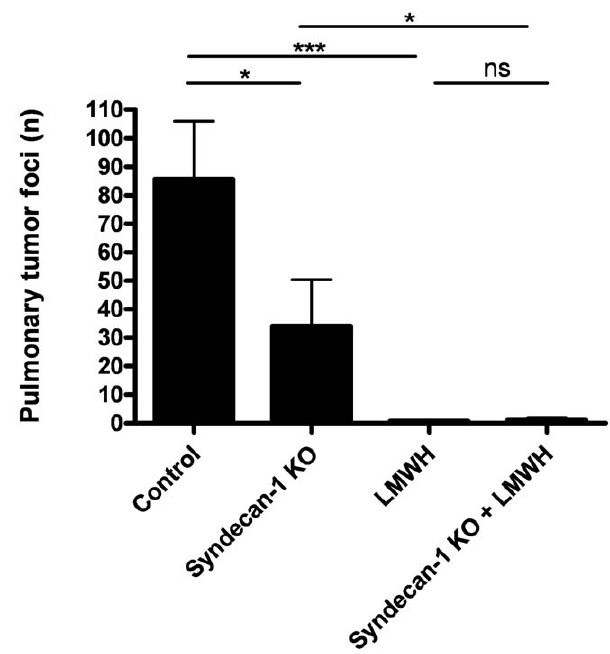
Figure 2. Pulmonary tumor foci formation in syndencan-1 2 / 2 versus wild type mice with and without treatment with LMWH. Syndecan-1 2 / 2 and wild type mice were administered 2.0 6 10 5 B16F10 melanoma cells into the lateral tail vein. One group of mice was treated with LMWH (15 mg/kg enoxaparin ) prior to the administration of B16F10 melanoma cells and LMWH treatment was repeated after 6, 12 and 24 h. Mice were sacrificed 14 days after cancer cell injection and the number of tumor foci at the surface of the lungs was determined. Error bars represent medians 6 interquartile range (n=8), * p , 0.05; *** p , 0.001.